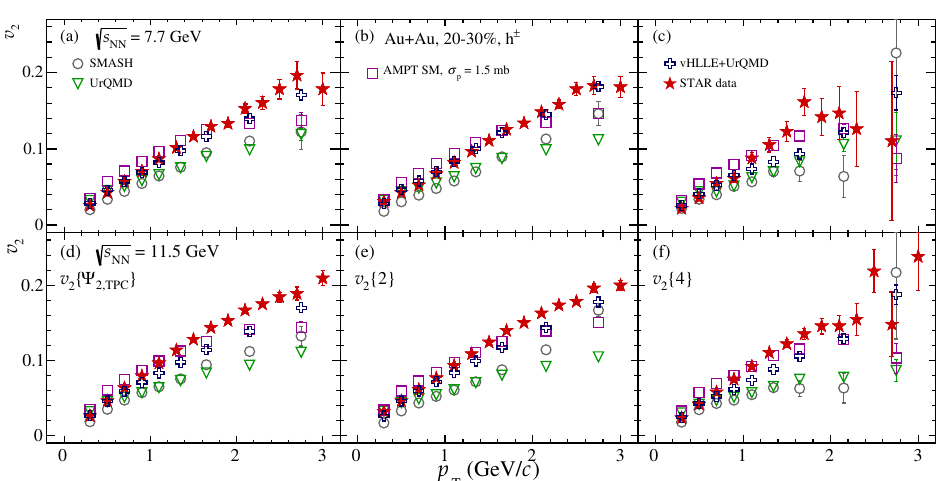
Figure 2. p T -dependence of v 2 of inclusive charged hadrons from 20–30% centrality Au+Au collisions √ s NN = 7.7 GeV (upper row) and 11.5 GeV (lower row) obtained using v 2 { Ψ 2,TPC } ( a , d ), v 2 { 2 } at ( b , e ), and v 2 { 4 } ( c , f ) methods of flow measurements in comparison with STAR data